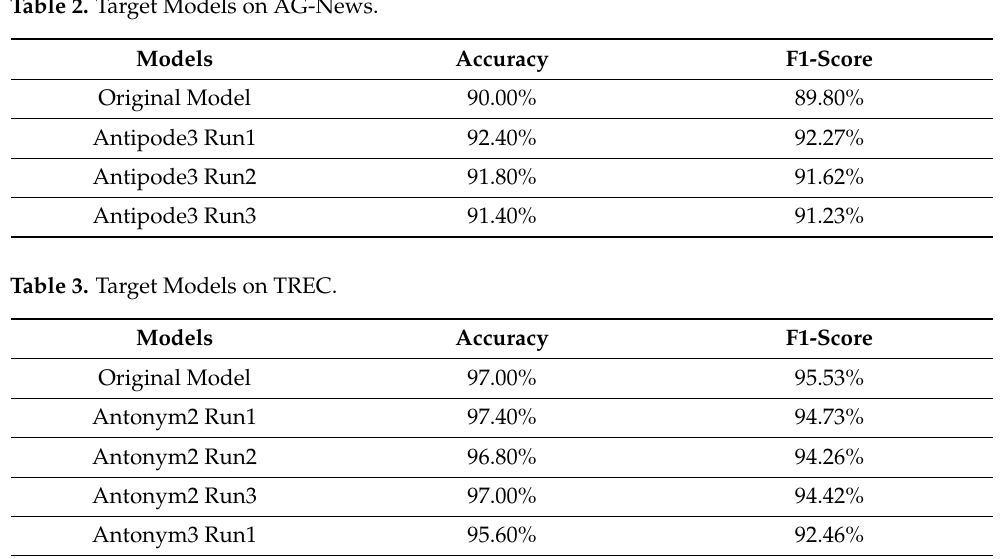
Table 2. Target Models on AG-News.